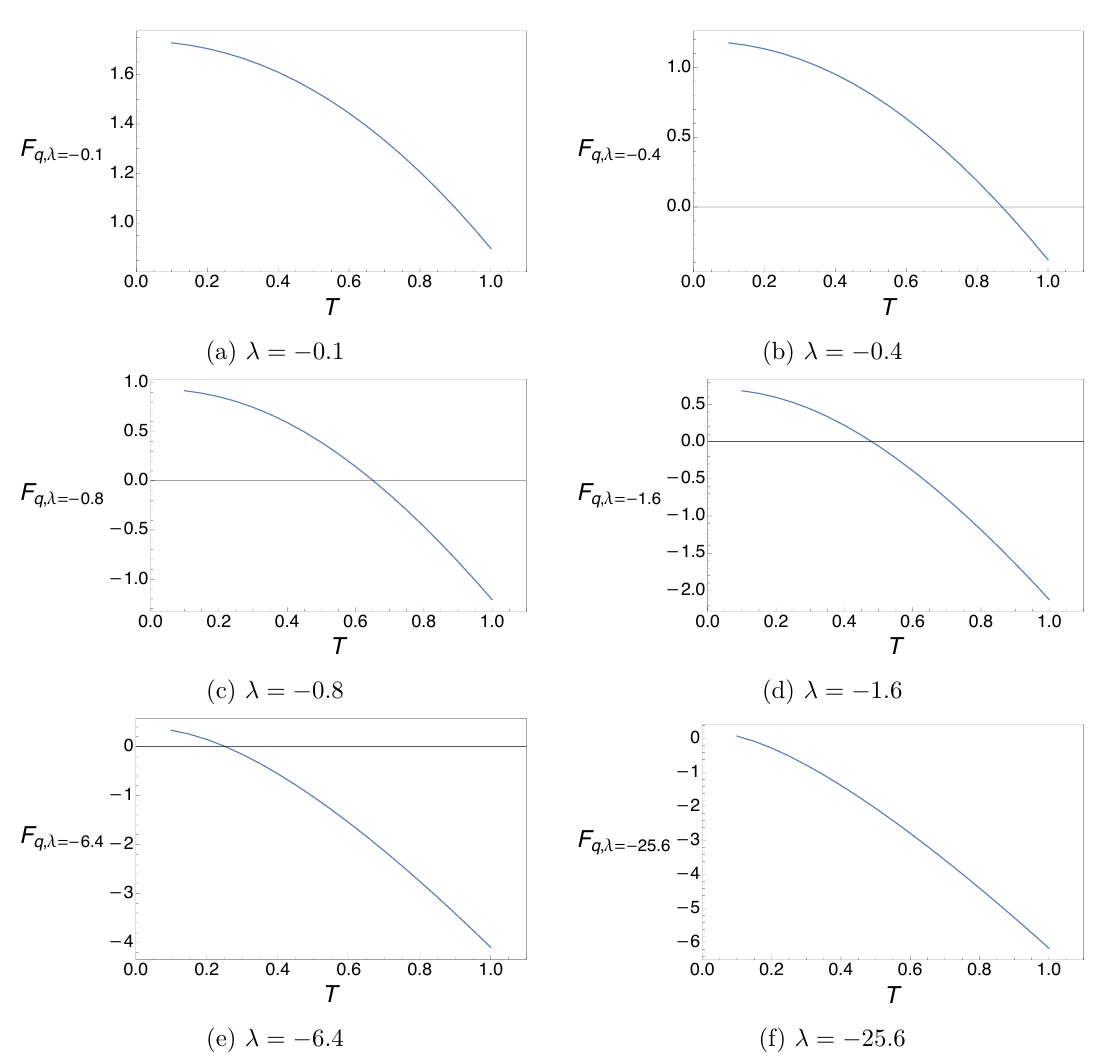
Figure 8. We plot the quenched free energy F q,λ ( T ) without the contribution from the non- perturbative branch as a function of T for λ = − 0 . 1 , − 0 . 4 , − 0 . 8 , − 1 . 6 , − 6 . 4 , − 25 . 6 . As shown, F q,λ ( T ) is a monotonically decreasing function of T in the deformed